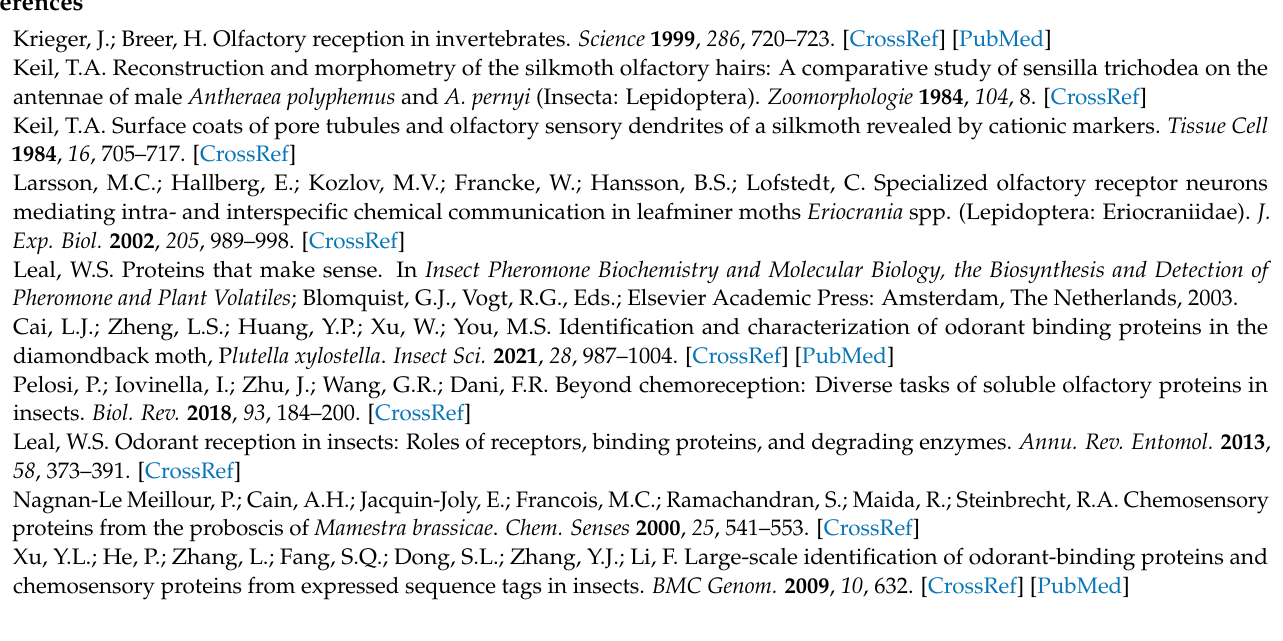
Figure S2: Chart showing level absorbance at 600 nm that represents the bacterial growth of E. coli cells expressing HarmCSP6 and HarmCSP22 in LB and M16 media. Figure S3: Densiometric quantifi- cation of protein band showing relative soluble or insoluble expression of HarmCSP6 and HarmCSP22 in LB and M16 media. Table S1: The nucleotide sequences, amino acid sequences, scaffold distri- bution, and other information of identified HarmCSPs. Supplementary Data S1. The amino acid sequences of insect CSPs for phylogenetic